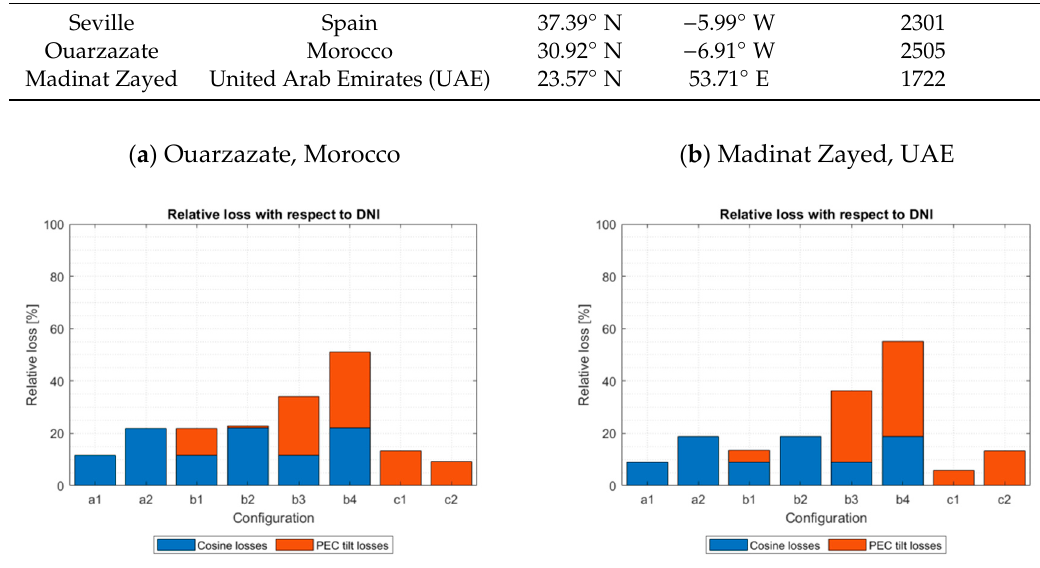
Figure 7. Relative losses with respect to DNI, caused by the collector cosine effect (blue) and the PEC(-PV) tilt constraints (red) for geometrical configurations listed in Table 5 and applied PEC(-PV) device tilt constraints (Figure 1c). ( a ) Ouarzazate, Morocco. ( b ) Madinat Zayed, UAE.